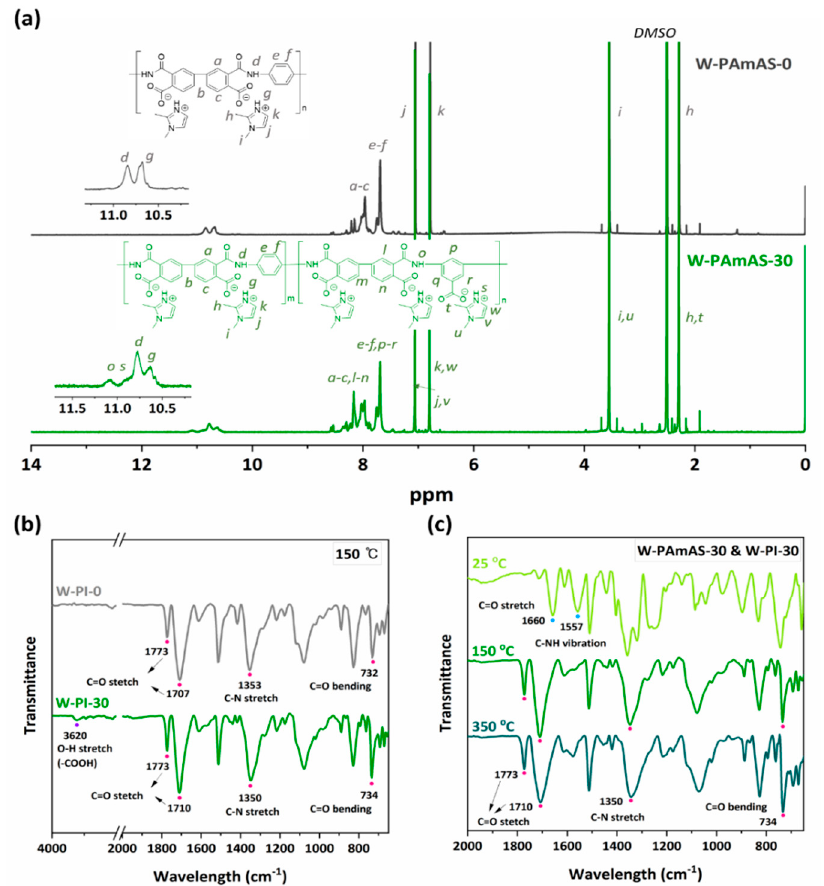
Figure 2. ( a ) 1 H NMR spectra of W − PAmAS − 0 and W − PAmAS − 30 in DMSO − d 6 . FT-IR spectra of ( b ) W − PI − 0 and W − PI − 30 thermally annealed at 150 °C for 6 h and ( c ) the effects of heat treatment temperature on the imidization of W − PAmAS − 30.